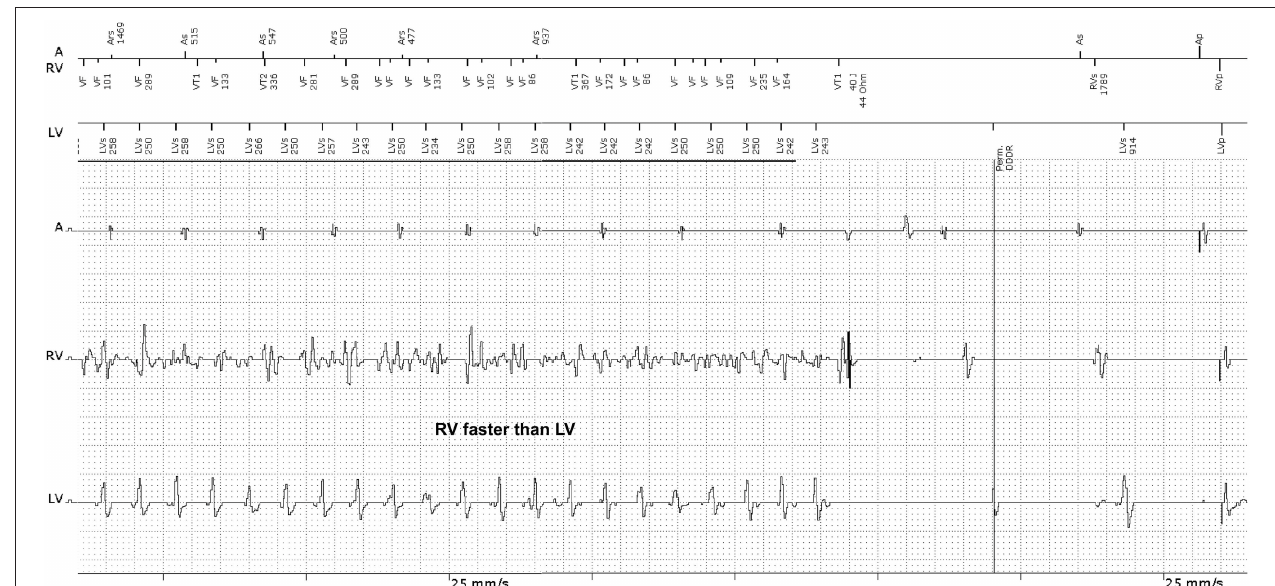
FIGURE 1 | EGM recording of a CRT-D device with appropriate VF detection during dissimilar ventricular tachyarrhythmia. The RV-EGM shows typical morphologies of VF, whilst the LV-EGM shows RR intervals of a quasi-stable ventricular tachycardia (VT). The ICD recognized VF correctly because the ICD detection is based on the RV electrode and delivered a 40 Joule shock, restoring sinus rhythm. A, atrium; RV, right ventricle; LV, left